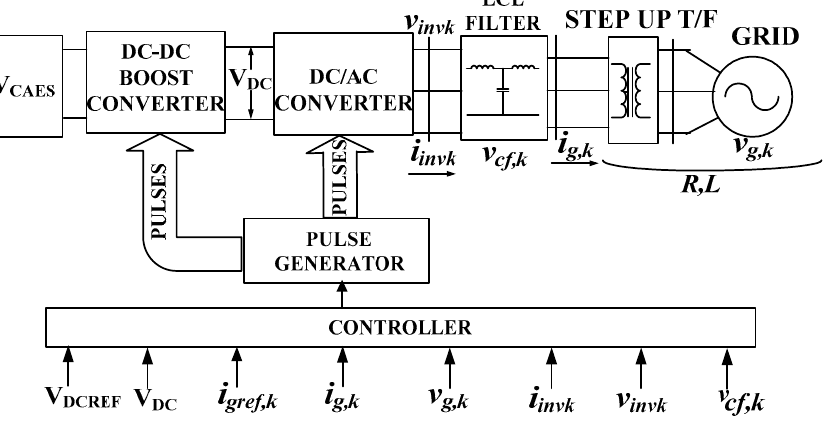
Figure 1. Block diagram of the system under study.